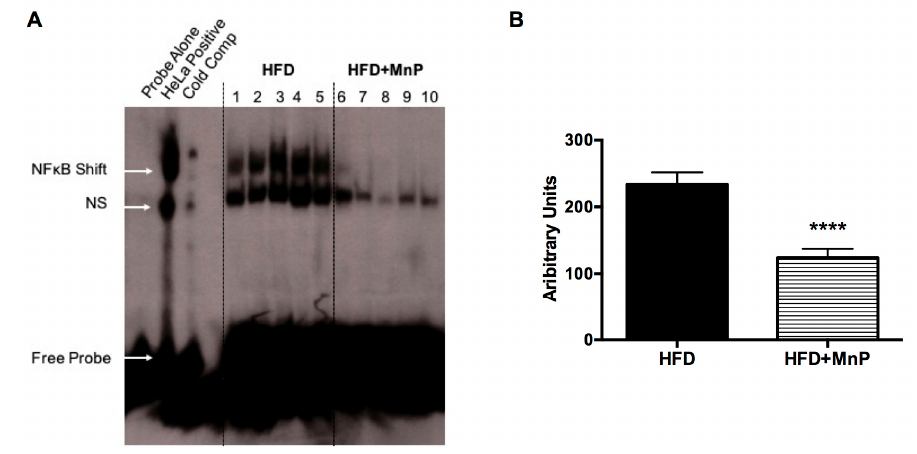
Figure 8. MnP treatment reduces NF- κ B binding in the liver. ( A ) After 12 weeks of HFD feeding, nuclear liver extracts from HFD and HFD + MnP mice were mixed with 32 P-labeled NF- κ B consensus oligonucleotide for Electrophoretic Mobility Shift Assay (EMSA). Control samples included 32 P-labeled NF- κ B probe alone, 32 P-labeled NF- κ B probe mixed with HeLa extract, and HeLa extract mixed with 50-fold excess unlabeled NF- κ B consensus oligonucleotide. Samples were resolved on a gel. The image displays the NF- κ B shift, non-specific binding (NS), and free probe. ( B ) Quantification of NF- κ B binding was measured by densitometry. Data are displayed as mean ± SD, n = 5 mice per group. Significance was calculated by t -tests. **** indicates p ≤ 0.0001.